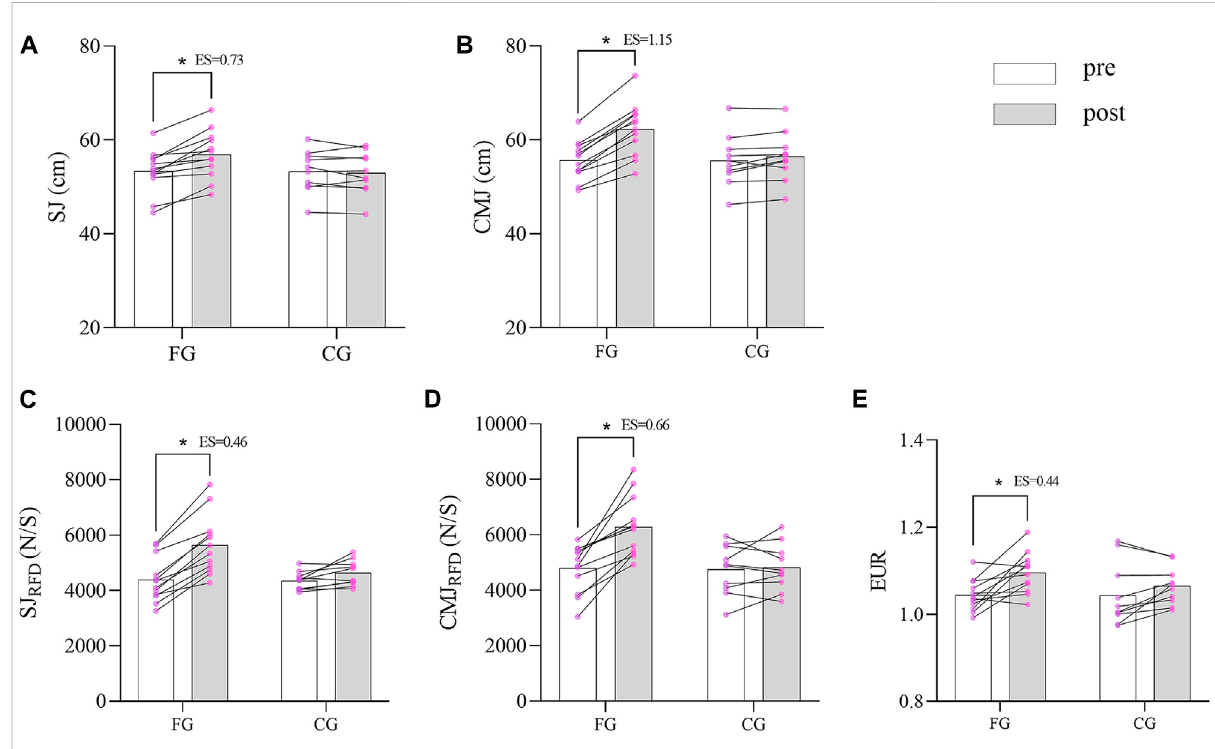
FIGURE 3 Change in Kinematic parameters between two groups (* p < 0.05; *** p <